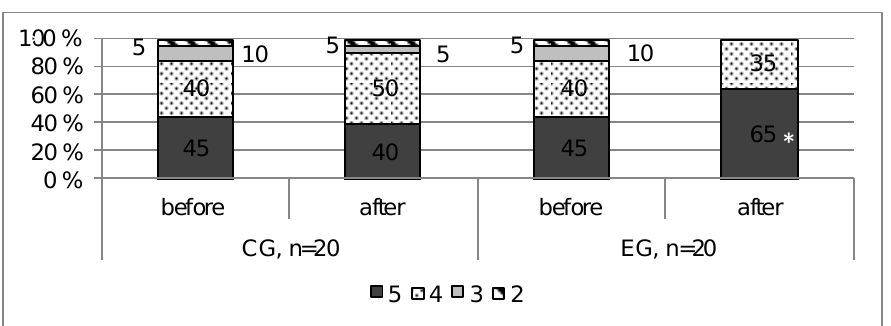
Fig. 3. Distribution of results of CG and EG before and after the experiment (n=40): * – is statistically significant difference, р<0,05; Assessment: C – high; D – good; E – average; F – satisfactory. CG – control group; EG – experimental group. before – before the experiment; after – after the experiment. 5 – perfectly; 4 – well; 3 – satisfactorily; 2 – unsatisfactorily. % – the quantity of